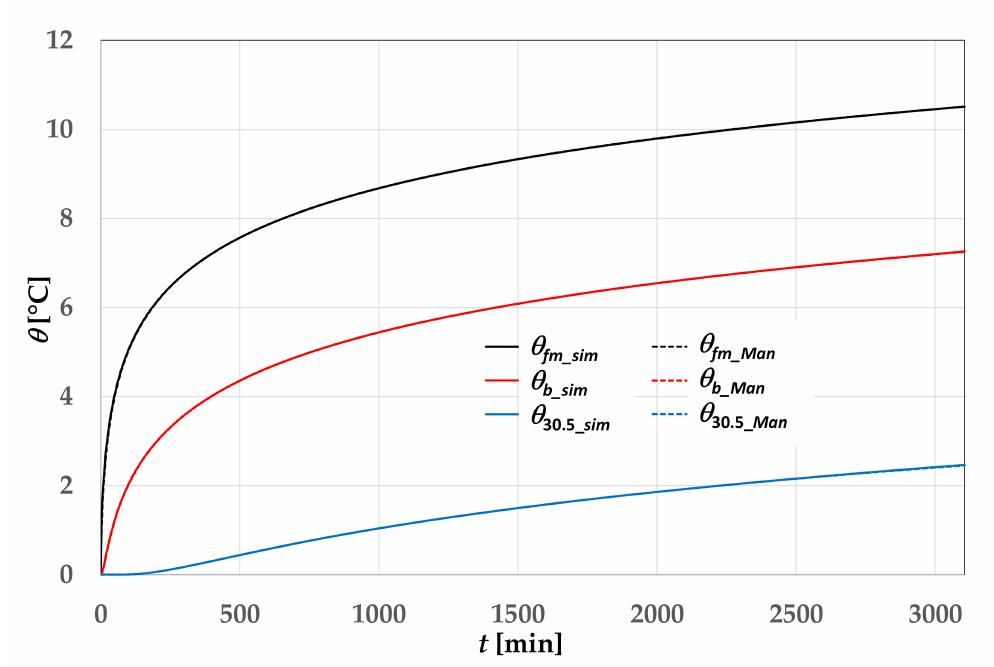
Figure 14. Time evolutions of θ fm , θ b , and θ 30.5 , for identical properties of BHE materials and sand, k s = 2.82 W/(mK), ( ρ c ) s = 3.2 MJ/(m 3 K): results obtained by 2D simulations, with subscript sim , and by Equation (7) with r 0 = 2.37 cm, with subscript Man .